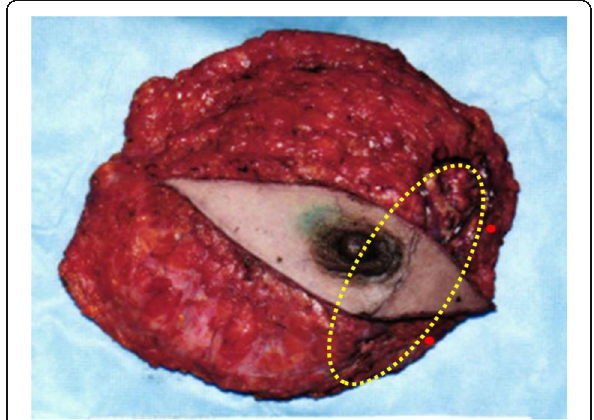
Fig. 4 Specimen obtained from the secondary surgery (the initial surgical site is marked roughly by the yellow oval). Two small nodules of angiosarcoma were observed in the peripheral part of the remnant right breast (red